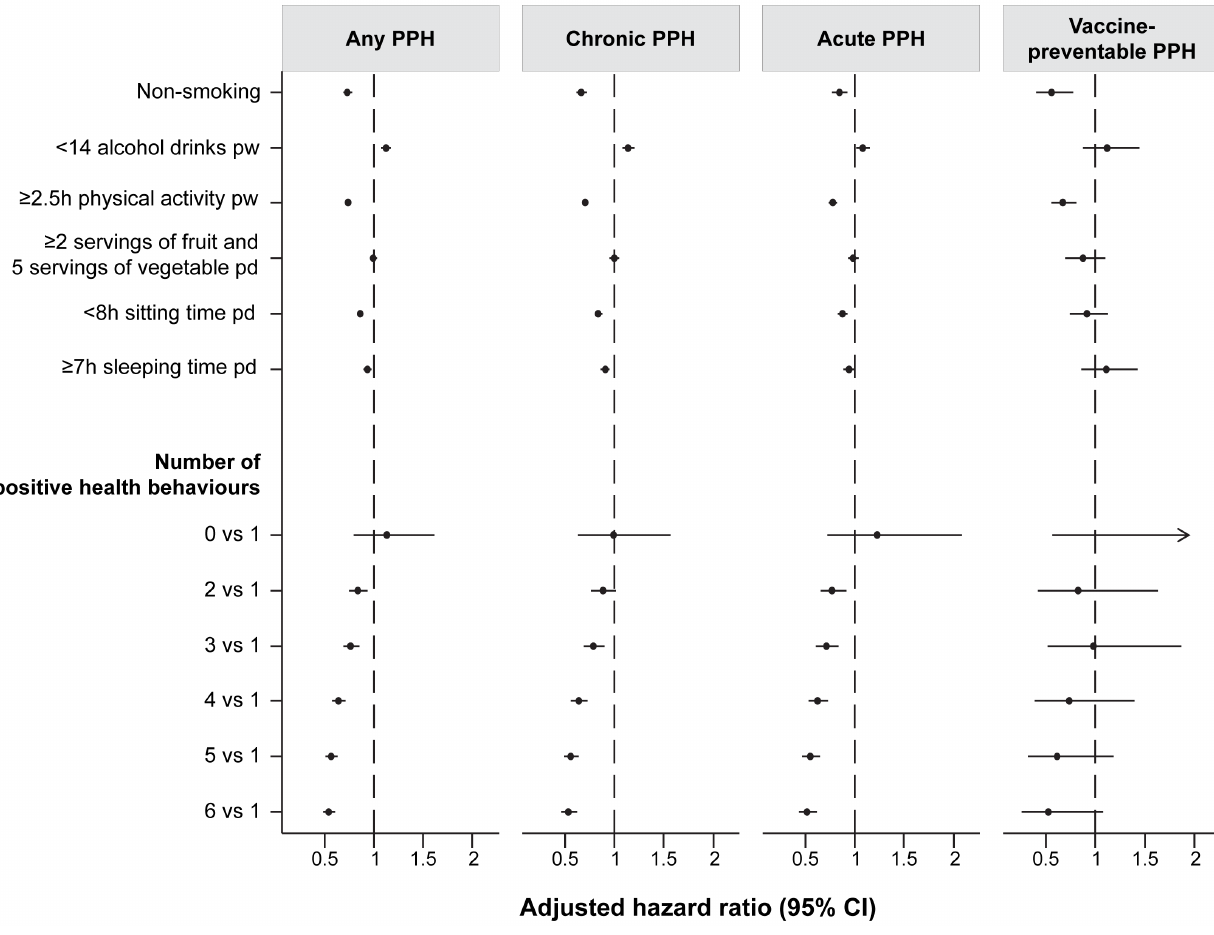
( Table S2 ). Mortality risk decreased linearly with increasing